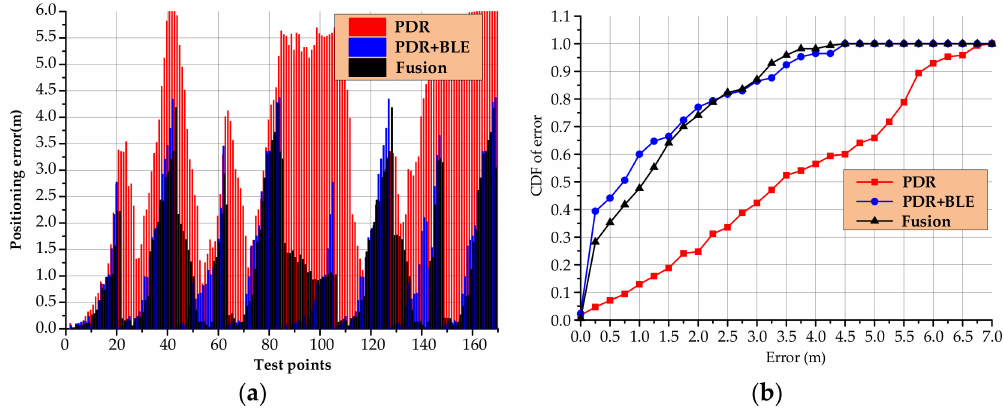
Figure 16. Statistical analysis of a large-scale indoor environment: ( a ) Linear distance error and ( b ) Cumulative error distribution